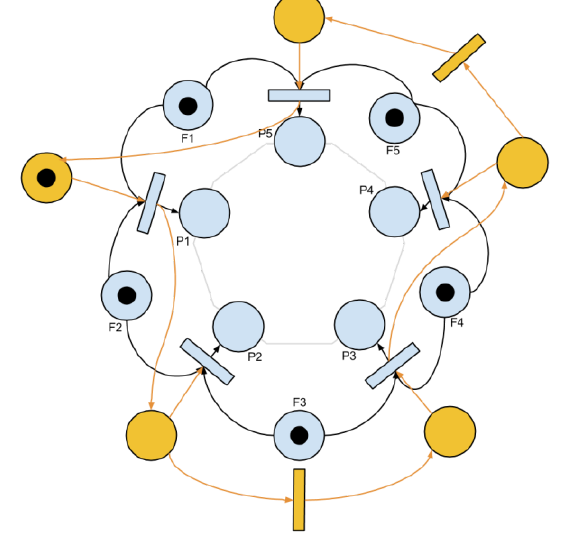
Fig. 9. Sequential model that emerges from AgentSheets and Scratch implementation analysis. Yellow elements represent the additions for tools to run the